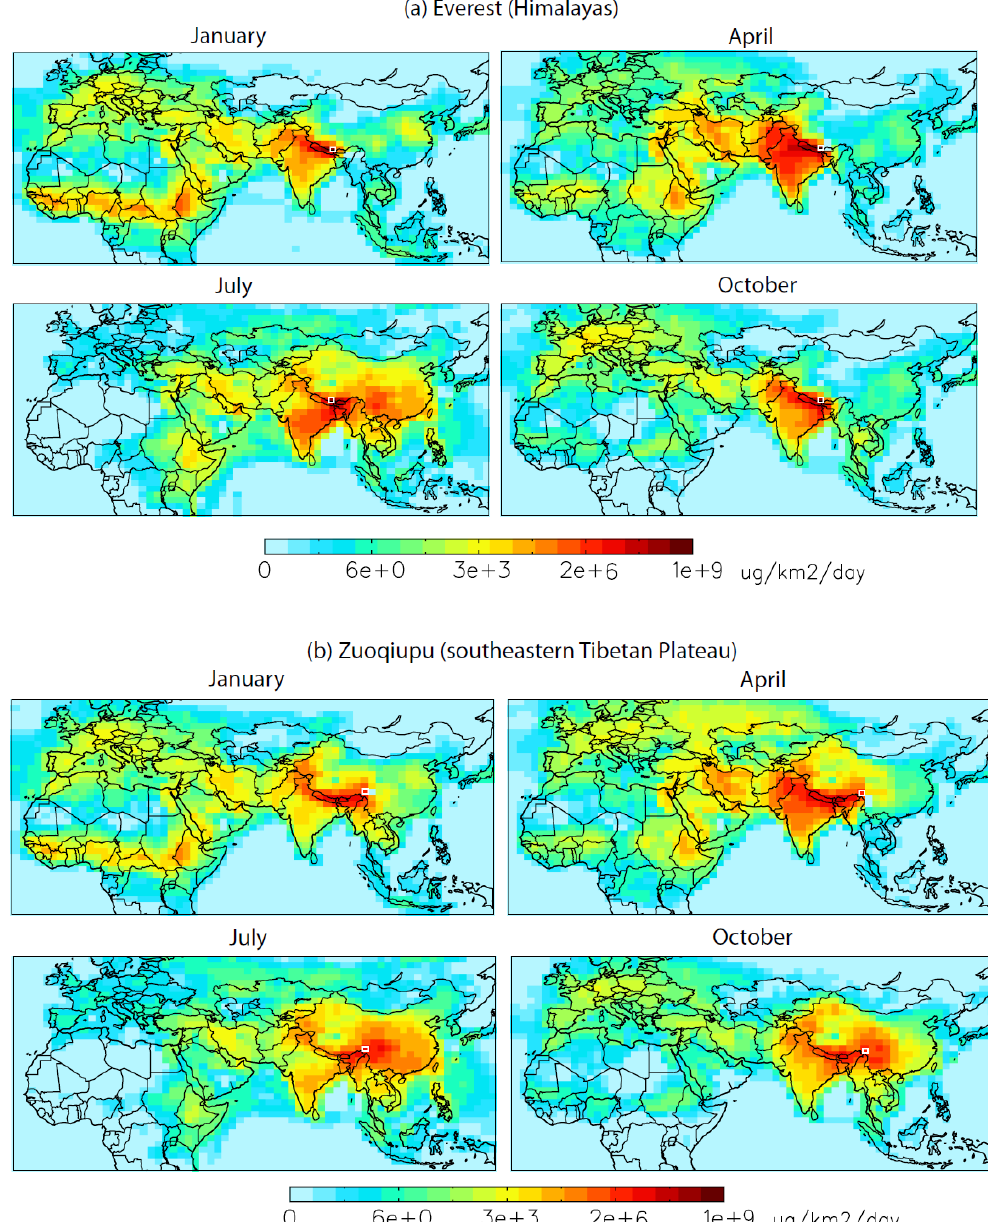
Fig. 5. Origin of black carbon by season (January, April, July, October) at five glacier sites throughout the Third Pole (a) Mt. Everest (Himalayas), (b) Zuoqiupu glacier (southeastern Tibetan Plateau), (c) Meikuang (northeastern Tibetan Plateau), (d) Mt. Muztagh (western Tibetan Plateau), and (e) Miao’ergou (north of Tibetan Plateau). The grid box containing each glacier site is outlined in white. The quantity of BC arriving at each glacier grid box from each grid box in the domain is indicated in